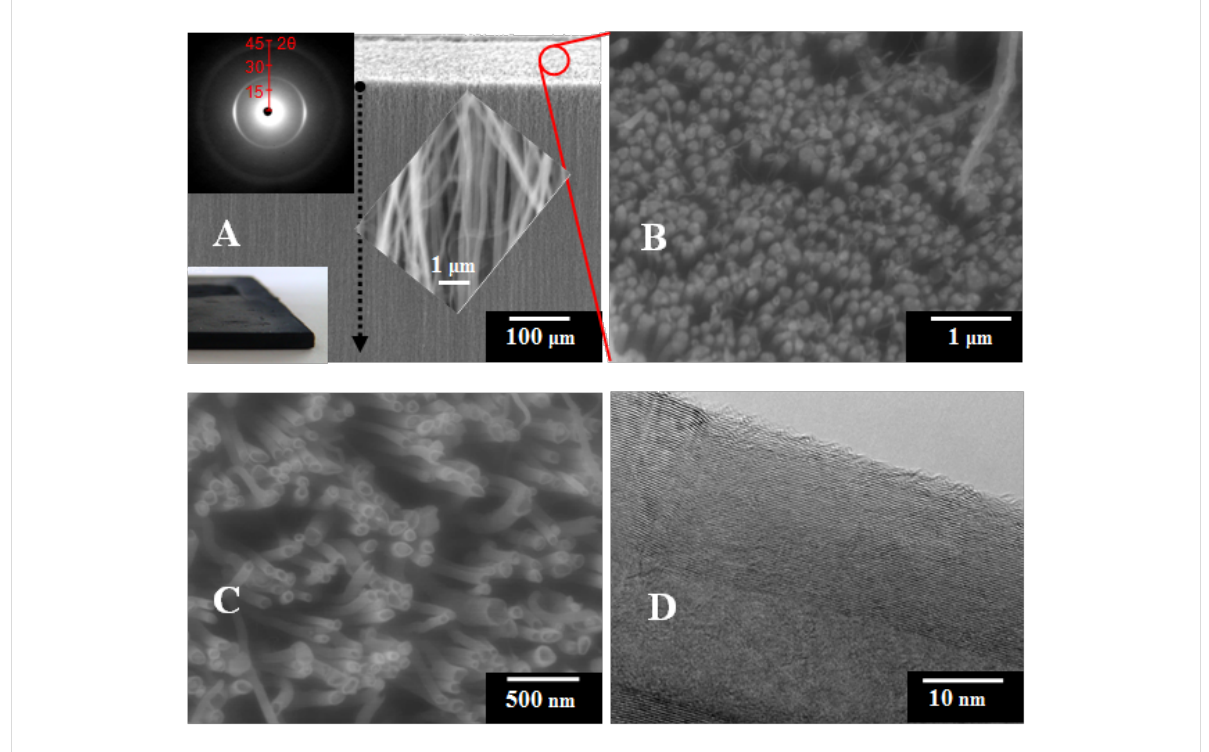
Figure 1: SEM micrographs (A–C): A side (A) and a top view (B) of the HACNT film grown on a quartz substrate; (C) a magnified top view of the film shows nanotube tips closed with iron catalyst nanoparticles, suggesting that CNTs were grown according both to tip-to-base and base-to-tip growth mechanisms; a representative TEM image (D) of a nanotube within the HACNT array. Insets in (A): lower left – a photograph of the as-grown HACNT array; upper left corner – a 2D wide-angle X-ray diffractogram of the HACNT film; central part – a side-view magnification showing degree of align- ment. A dashed arrow indicates the flow direction of tested liquids, opposite to the growth direction of the HACNT